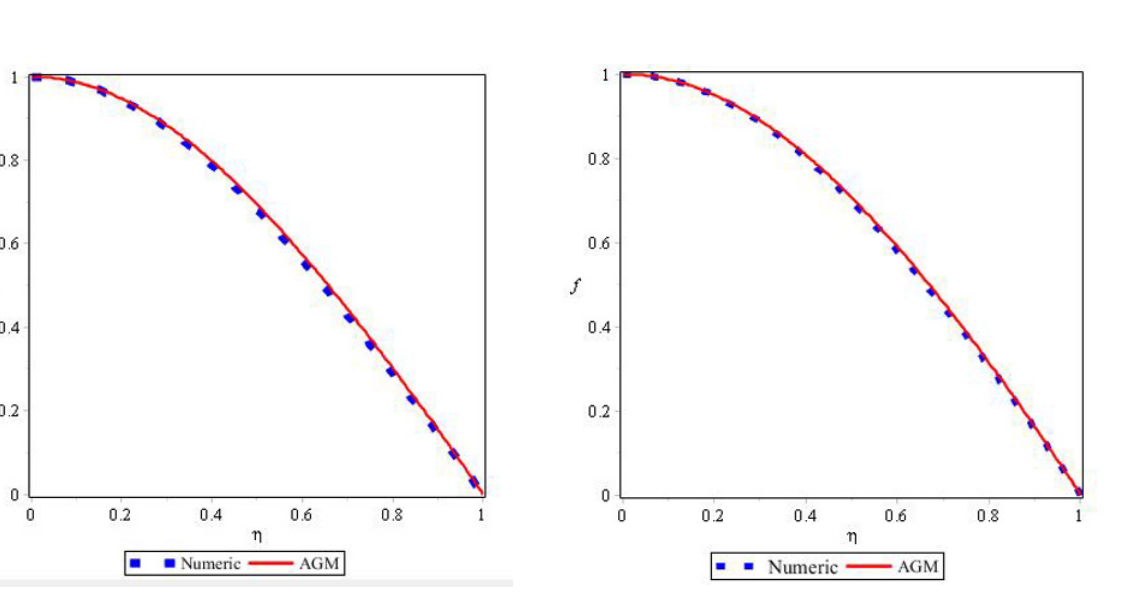
Figure 12. Comparison between the obtained solutions for f ( η ) by HPMandNumericalMethod( A ∗ = 1 , Ha = 0 , Re = 150 , α = 1 ◦ , φ = 0 ).